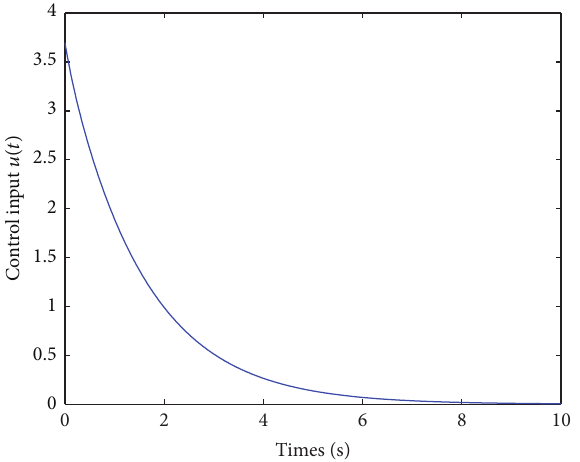
Figure 5: Evolution of the control input with